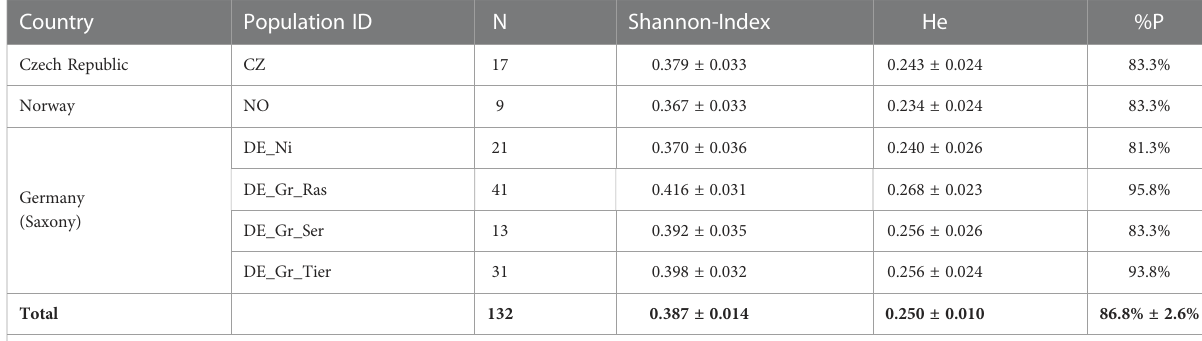
TABLE 2 Overview about estimators of genetic diversity in populations >5 samples.